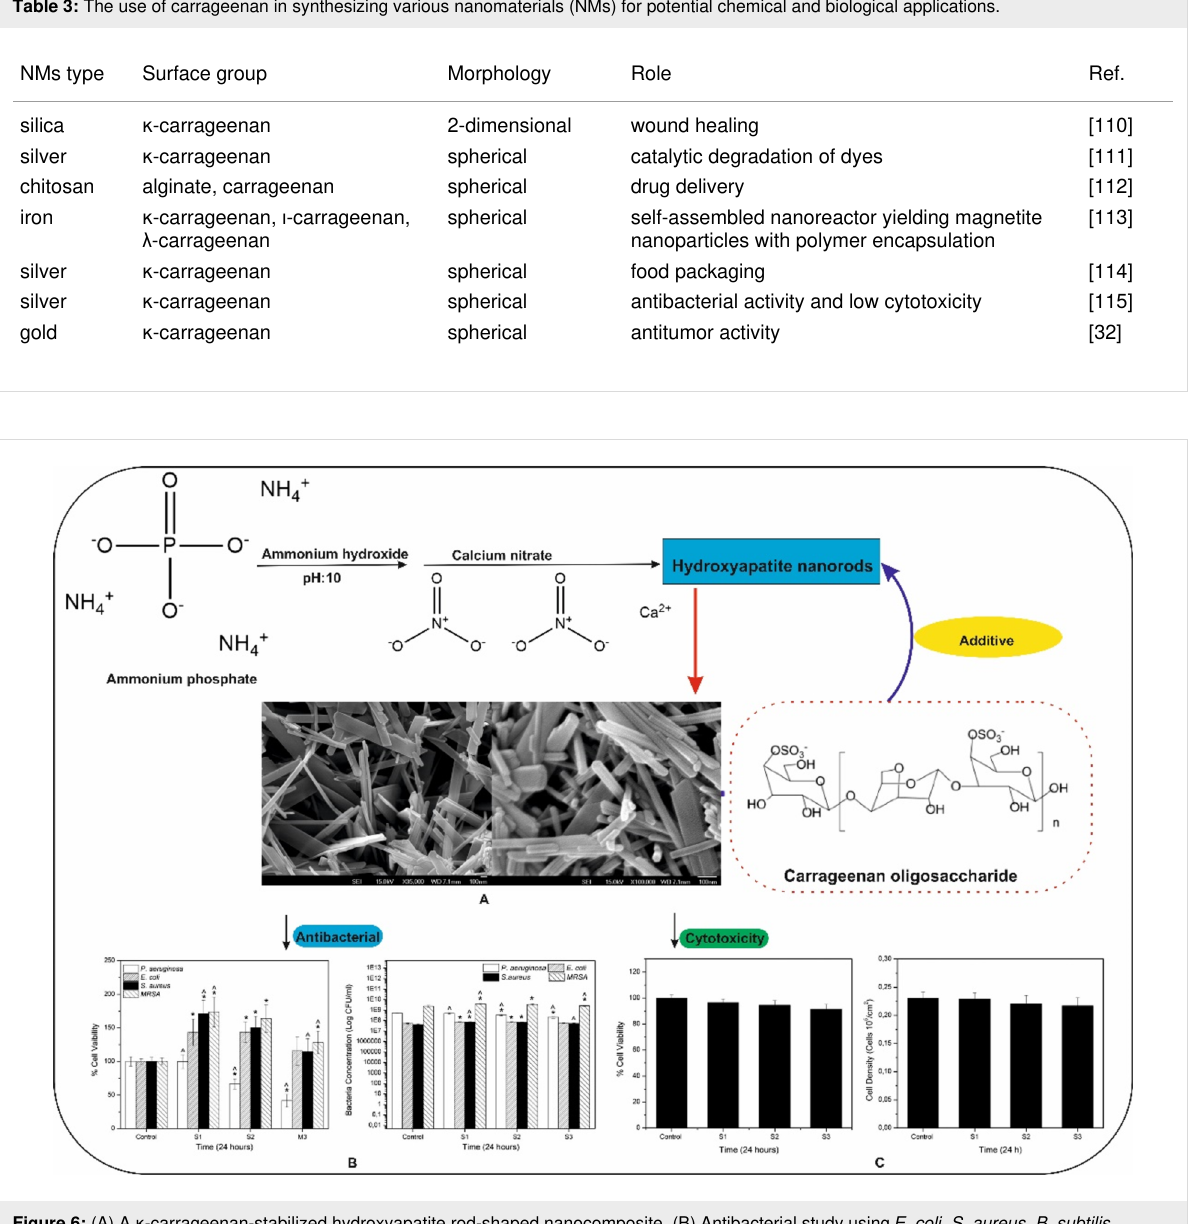
Figure 6: (A) A κ -carrageenan-stabilized hydroxyapatite rod-shaped nanocomposite. (B) Antibacterial study using E. coli , S. aureus , B. subtilis , P. aeruginosa showing the bactericidal properties of the nanocomposite. (C) The nanocomposite shows osteoblast cytotoxicity tests in cell lines (L02 and L929). Adapted from [116], J. I. González Ocampo et al., “Evaluation of cytotoxicity and antimicrobial activity of an injectable bone substitute of carrageenan and nano hydroxyapatite”, J. Biomed. Mater. Res. A., with permission from John Wiley and Sons. Copyright © 2018 Wiley Periodicals, Inc. This content is not subject to CC BY